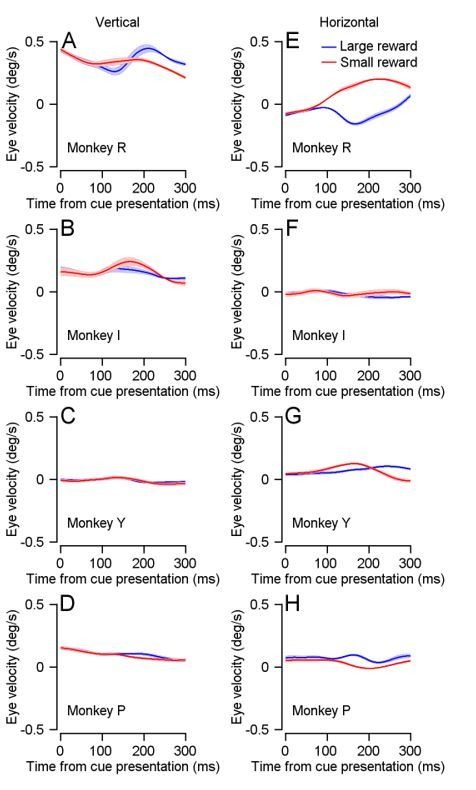
Drift following reward size cue presentation, measured using a coil.(A-D) Vertical drift velocity measured using coil following reward cue presentation. (E-H) Horizontal drift velocity measured using coil following reward cue presentation.